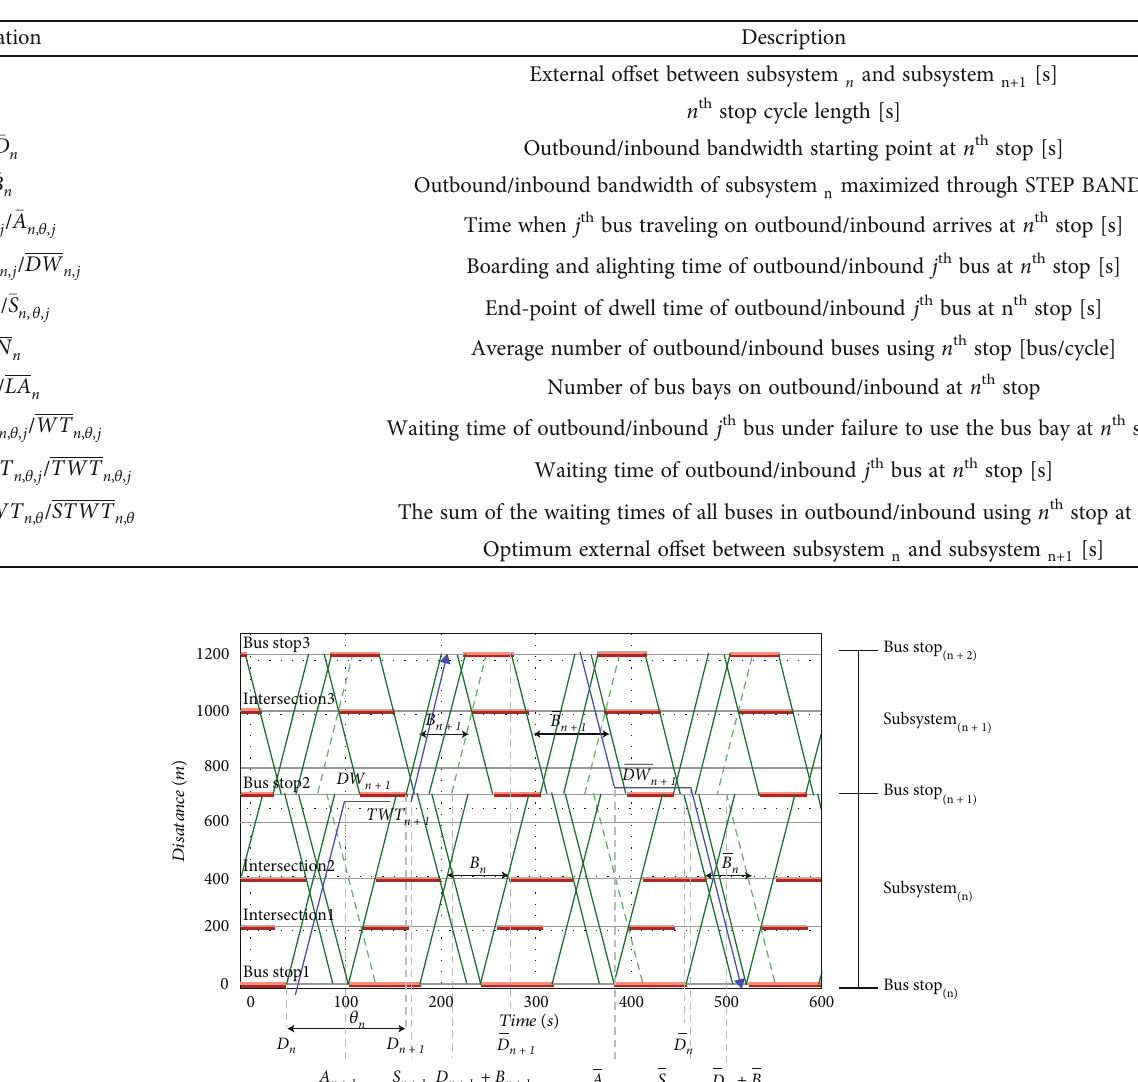
Figure 4: Time – space diagram for STEP BAND (symbols de fi ned in Table 1). Table 2: Additional